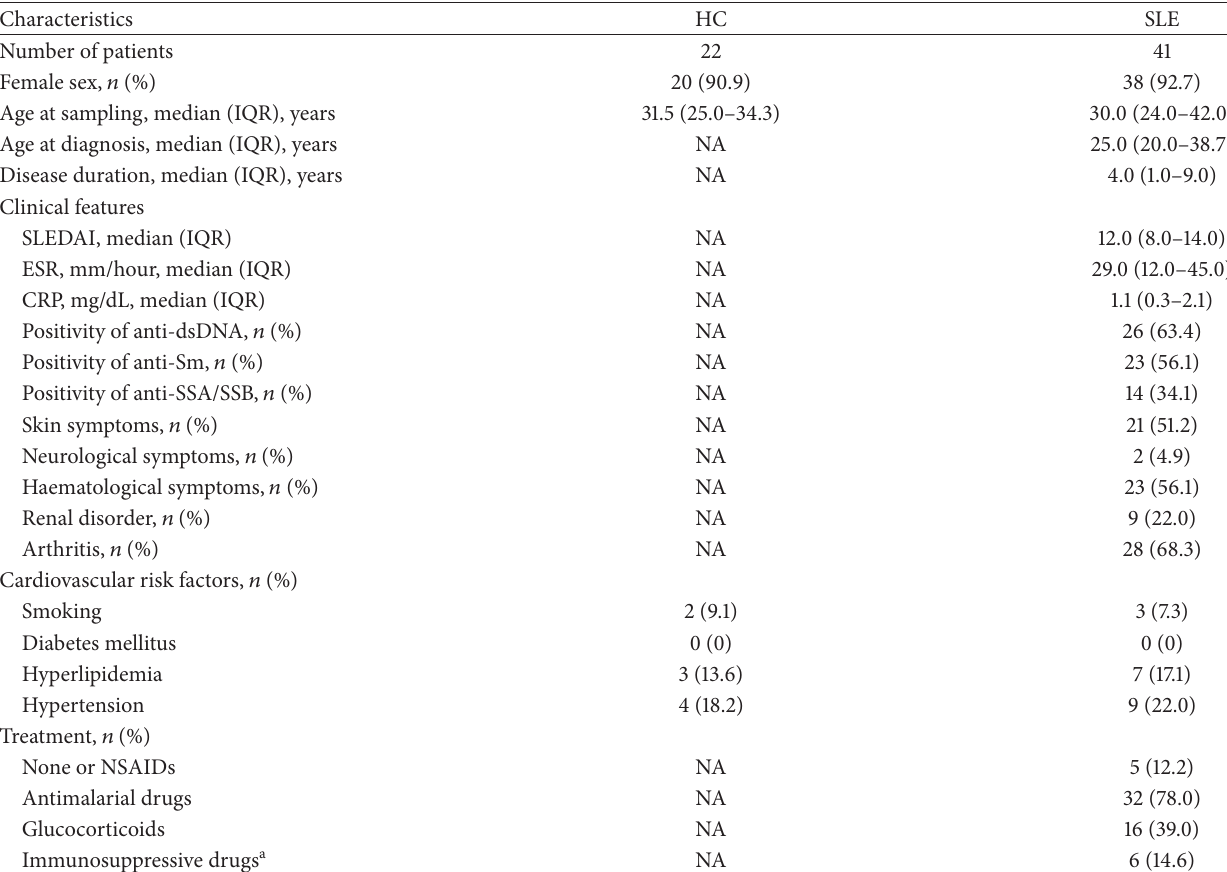
Table 1: Clinical and laboratory characteristics of SLE patients and healthy controls